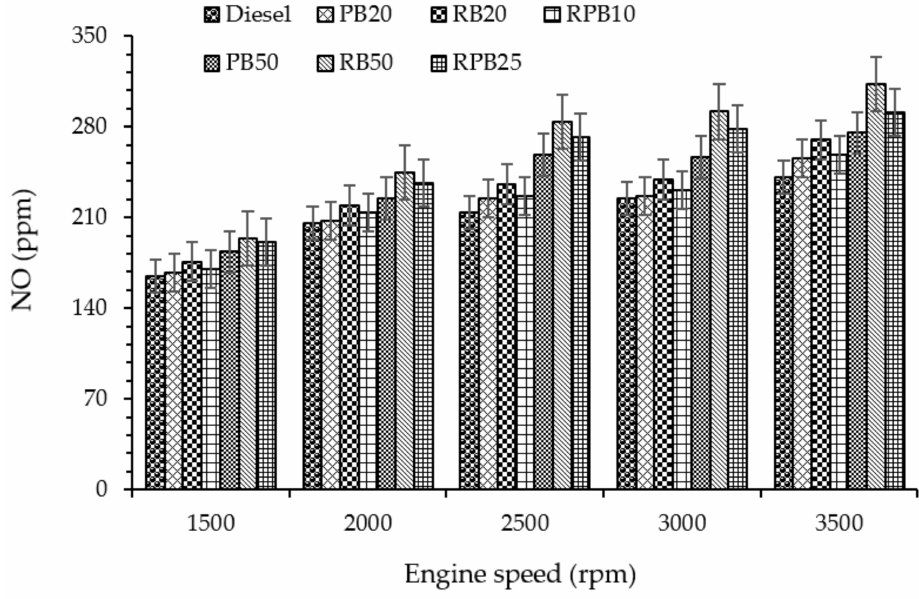
Figure 9. Variation of nitrogen oxide (NO) emission with respect to engine speed.